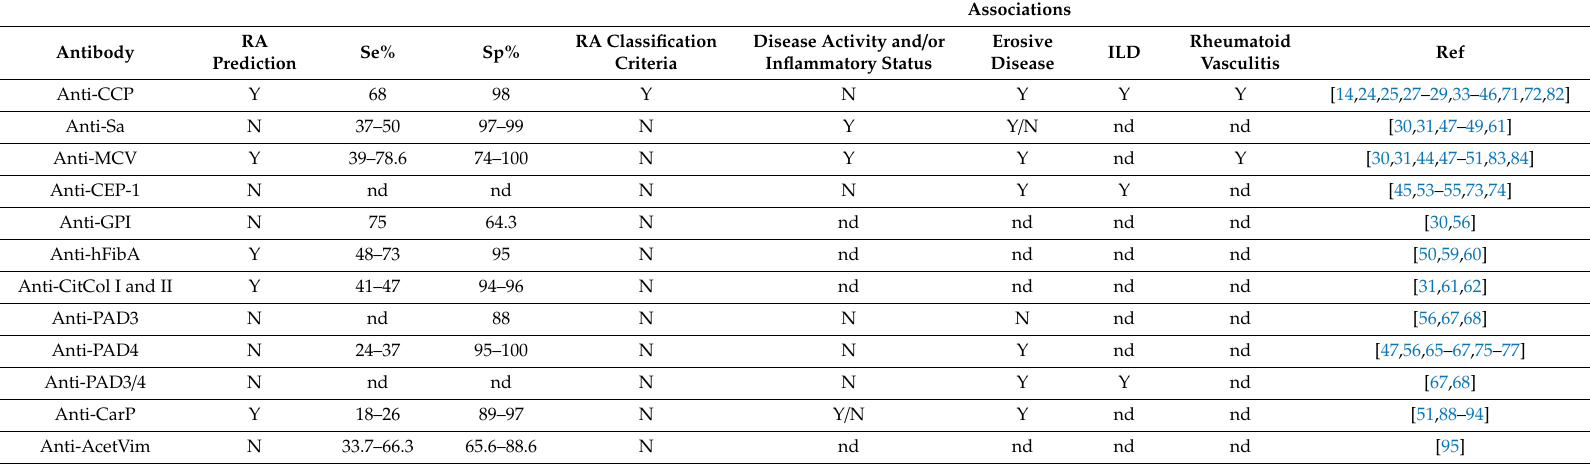
Table 1. Role of antibodies against post-translationally modified proteins in rheumatoid